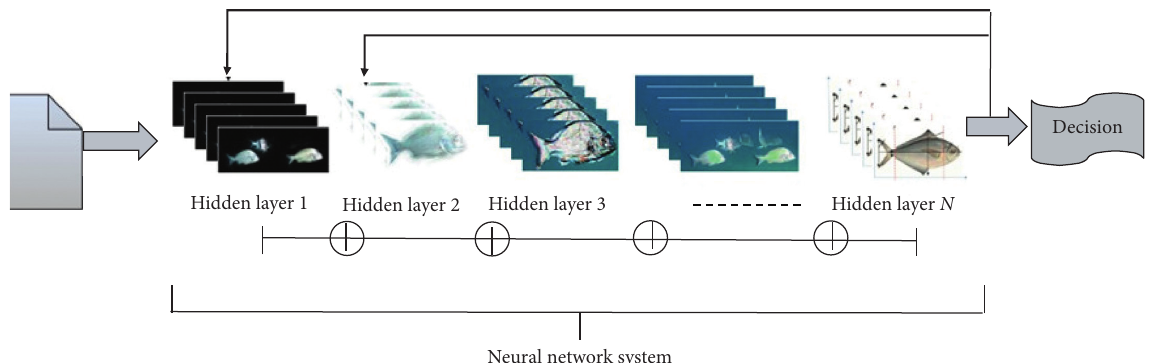
Figure 9: Proposed deep neural network system shows variable generated features within the system.